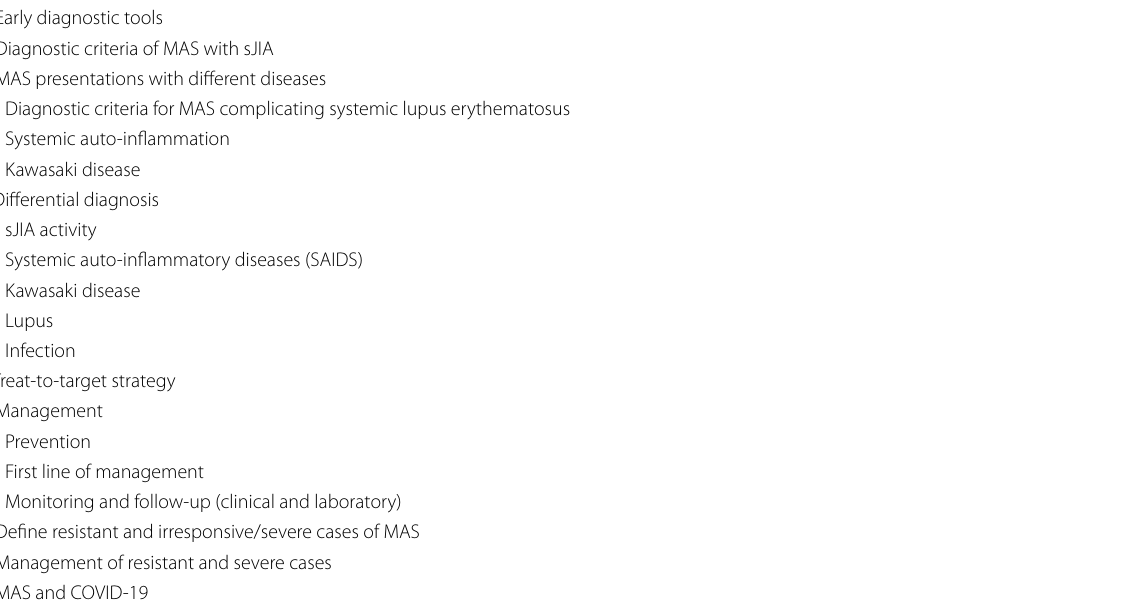
Table 1 Key questions used to develop the